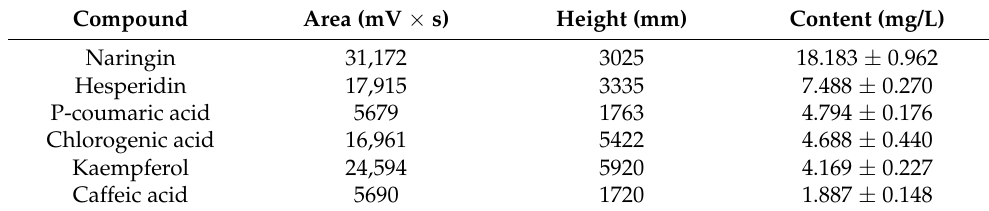
Table 4. The constituents of GF analyzed by UPLC.